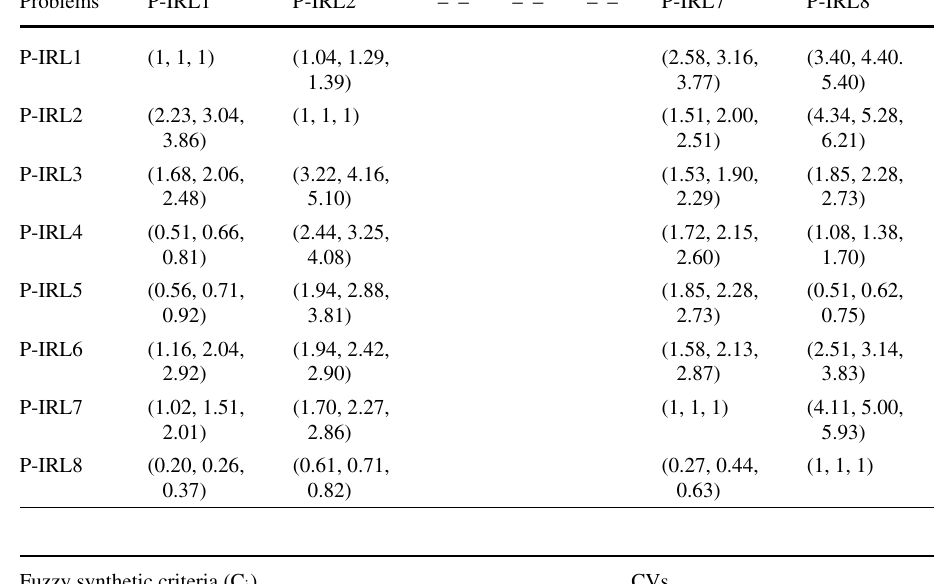
Table 6 Fuzzy synthetic extent values (CVs) for IRL